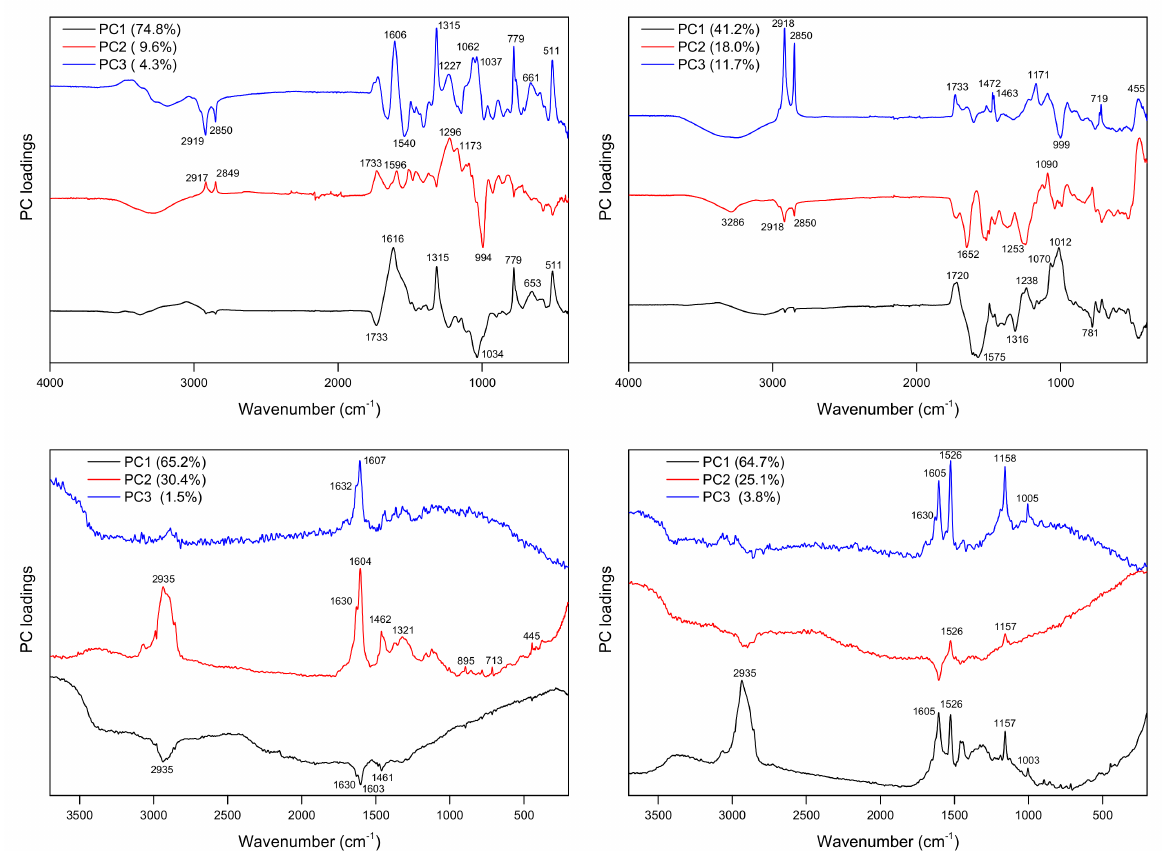
Figure 6. PCA loadings for poplar bark ( left ) and leaves ( right ) calculated on the basis of ATR ( top ) and Raman ( bottom )